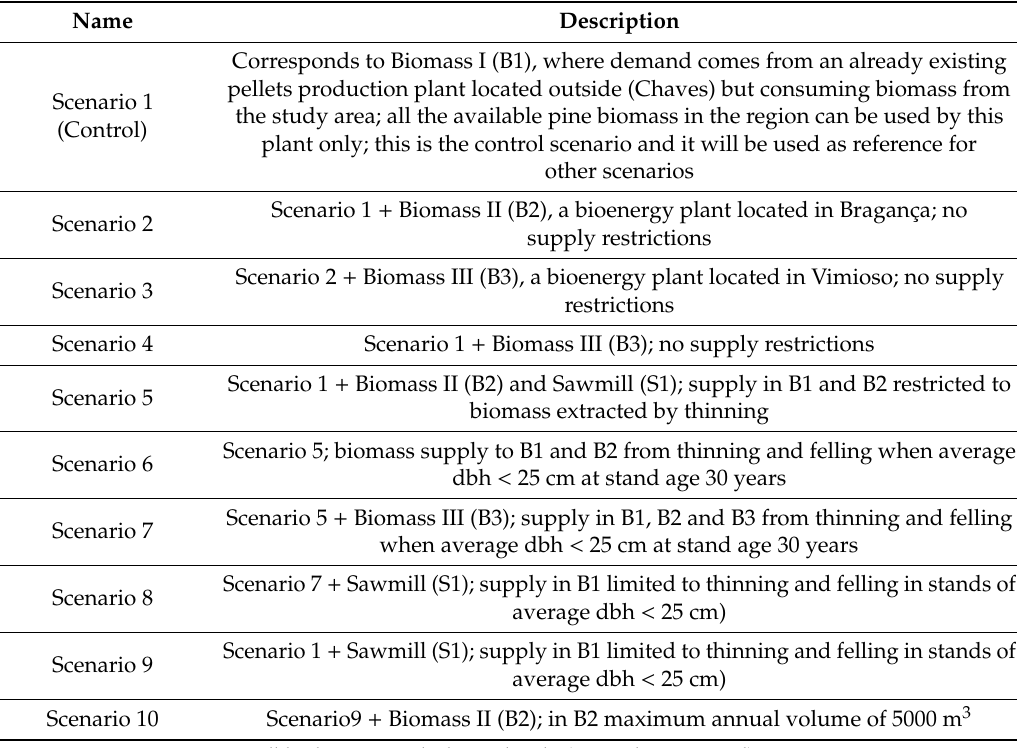
Table 2. Description of scenarios tested in the Nordeste region,